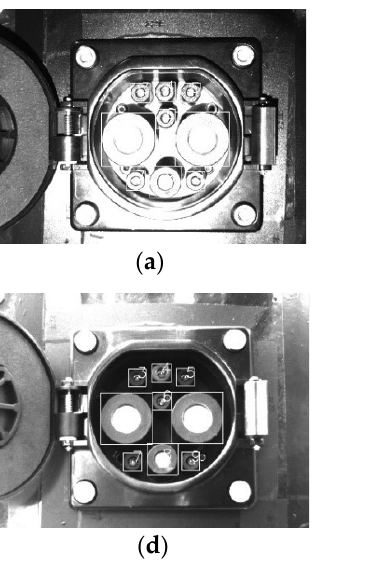
Table 4. Pose errors in the aiming phase.